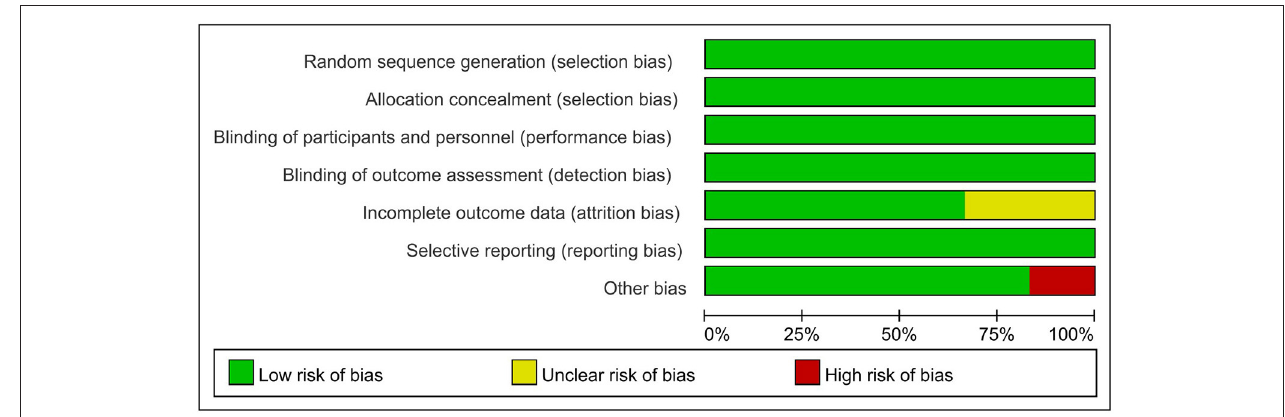
FIGURE 2 | Risk of bias graph for included